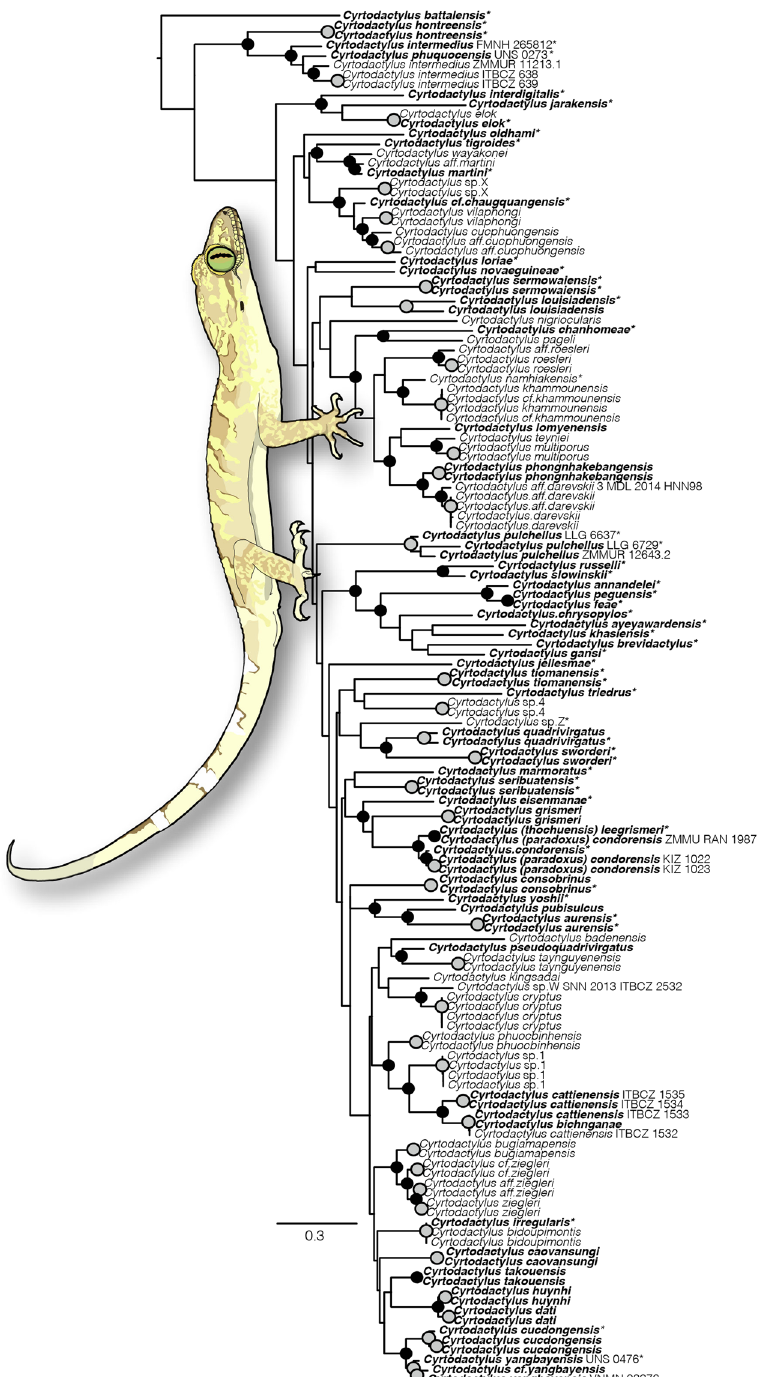
Figure 1. ‘Fully-sampled’ maximum likelihood phylogeny of Cyrtodactylus as inferred from mitochondrial locus COI , including novel sequences contributed by this study (51) indicated by asterisks. Circles at nodes indicate BSS values of ≥ 70: grey indicate intraspecific sampling and black interspecific sampling. Bolded names indicate samples also included in the ‘Standardized ND2 ’ phylogeny (Fig. 2). Sample numbers are included to aid in determining relationships in cases where more than 2 samples were used for a given species, or species are reconstructed as paraphyletic. Cyrtodactylus pubisulcus image drawn by IGB from photograph courtesy of Ben